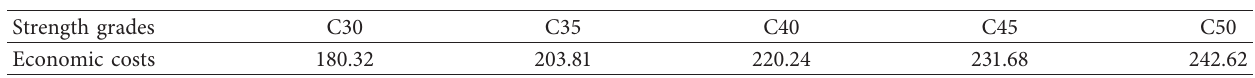
Table 9: Cost of different strength grades coal gangue-based geopolymer concrete based on Logistic mapping optimization (yuan/m 3